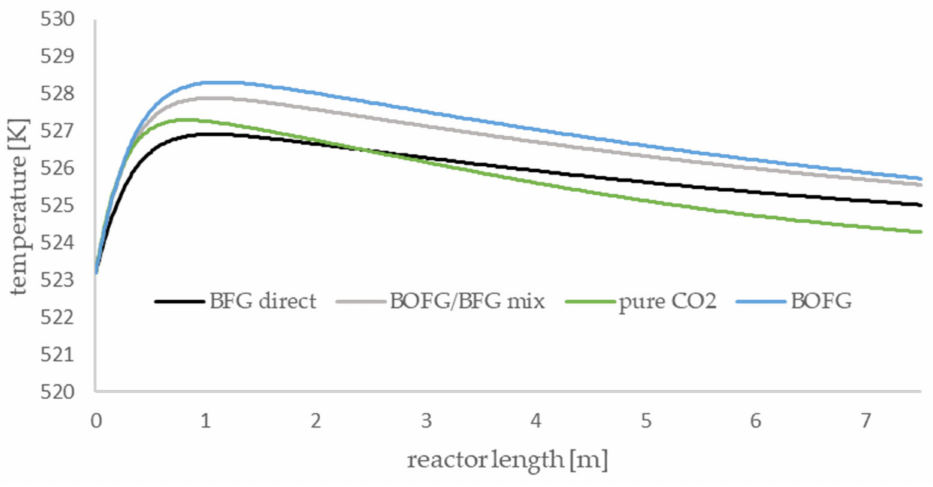
Figure 6. Axial temperature profile of the gas utilization scenarios at a recycle ratio (RR) of